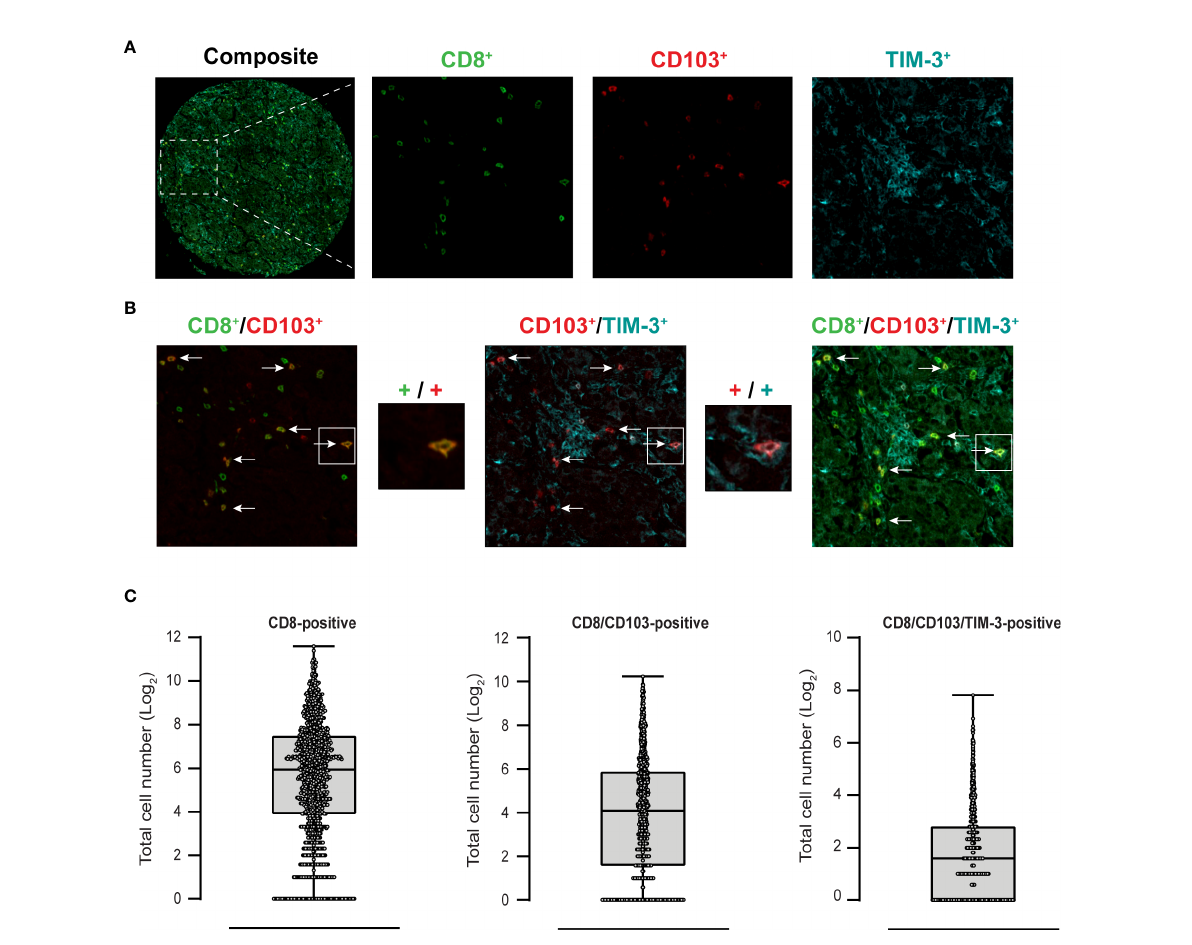
FIGURE 1 Tumor in fi ltration of immune cell subsets CD8-positive, CD8/CD103-positive and CD8/CD103/TIM-3-positive in EOC core samples. Exemplary processed IHC slide stained with antibodies targeting CD8 (green), CD103 (red) and TIM-3 (cyan) and corresponding secondary antibodies (A) . TMA sections were scanned using a TissueFAXS imaging system. Processed channels were merged using ImageJ. Fluorescent overlay analysis revealing CD8/CD103 double-positive, CD103/TIM-3 double positive and CD8/CD103/TIM-3 triple-positive cells (B) . Single-, double- and triple- positive cell populations were counted using ImageJ. Total raw cell counts of the single-, double- and triple-positive cell populations are Log2 transformed and displayed in (C)